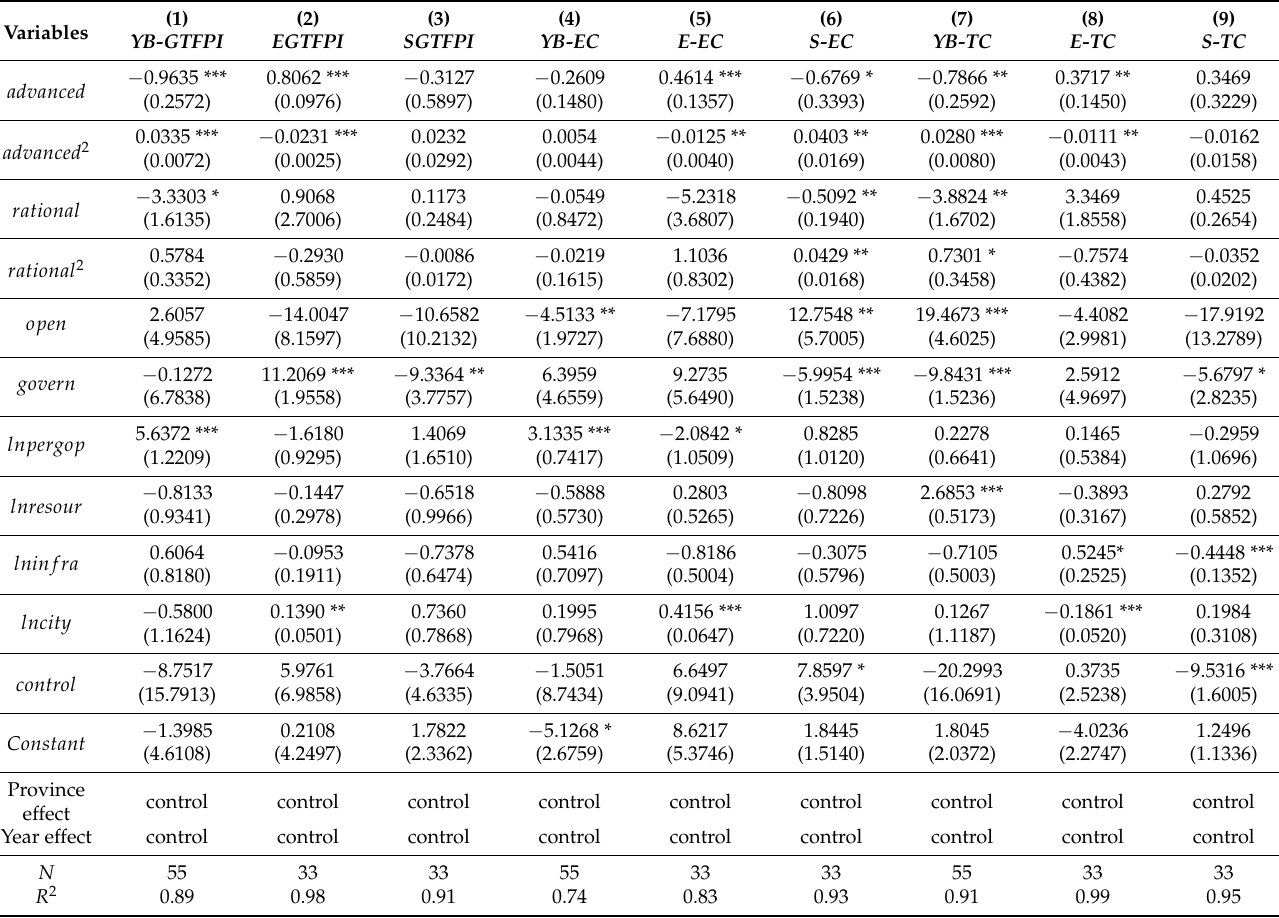
Table 3. Heterogeneity Test Based on Sea